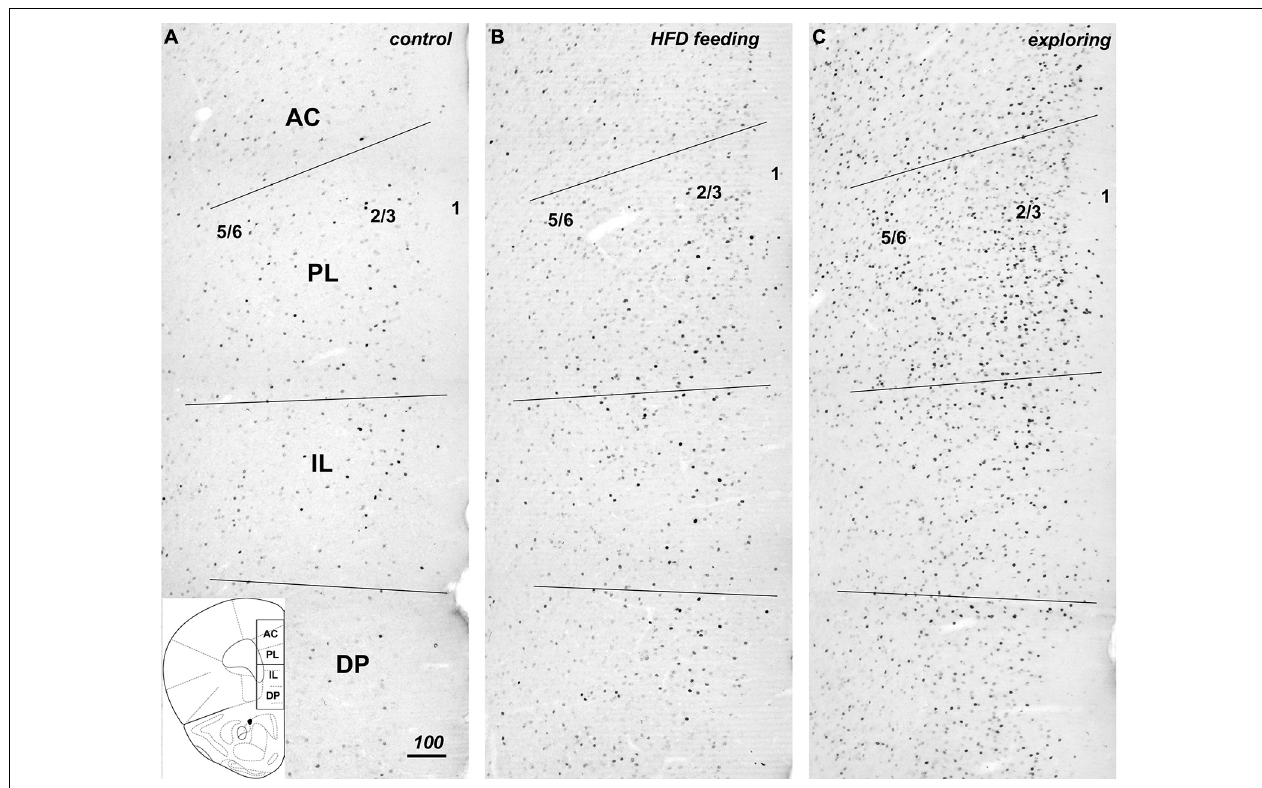
photomicrographs taken from the left hemisphere mPFC. The increase in Fos immunreactivity was evident in both deep and superficial layers of these regions (B,C) . The coronal diagram in the lower left depicts the corresponding area and includes the dividing line for purpose of analysis of the dorsal and ventral halves. Scale bar in A = 100 μ m, and applies to all